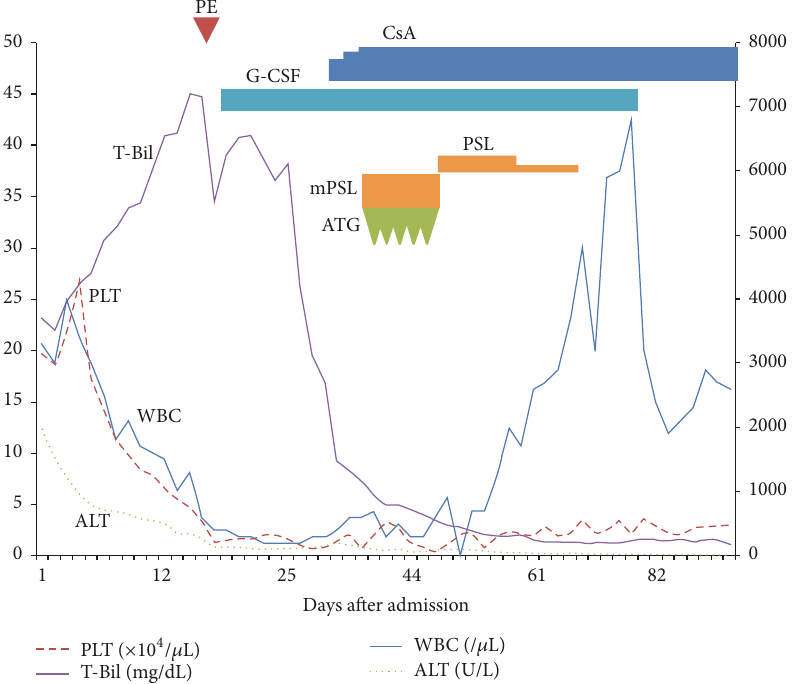
Figure 1: The change in laboratory investigation and the course of treatment. PLT, platelet; T-Bil, total bilirubin; WBC, white blood cell count; ALT, alanine aminotransferase; PE, plasmapheresis; G-CSF, granulocyte colony-stimulating factor; CsA, cyclosporine; ATG, anti-thymocyte globulin; mPSL, methylprednisolone; PSL, prednisolone.